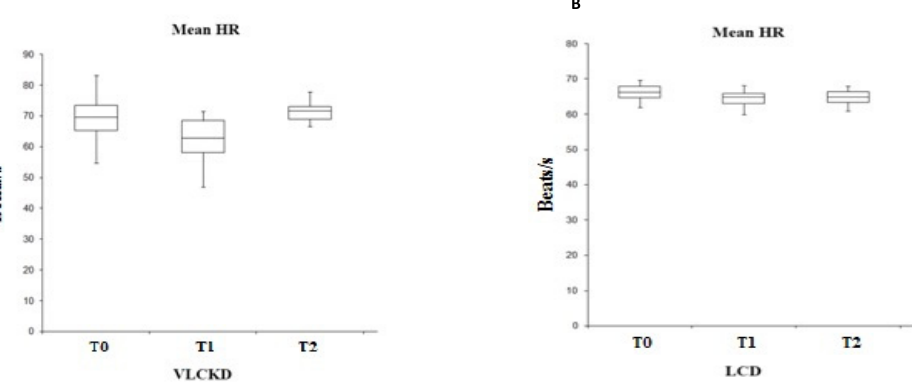
Figure 2. Variability of the mean HR in VLCKD subjects ( A ) and in LCD subjects ( B ). By evaluating the mean-RR parameter (temporal distance between two heartbeats, expressed in ms), the trend in the two groups is similar, with an increase at T1 and a reduction at T2 (Figure 3). However, this variability is statistically significant only in the group subjected to a ketogenic diet (F (2.25) = 0.003, p < 0.01). Analyzing the HF parameter (Figure 4), we find, as expected, a trend similar to that of the RR variability, with a significance in the ketogenic diet group (F (2.25) = 0.002, p < 0.01). Instead, by evaluating the sympathetic activity through the analysis of the LF (Figure 5), its variability is closely correlated with the HR: in fact, the trend is similar with a reduction at T1 and an increase in values at T2. However, this variability is statistically significant only for the group subjected to VLCKD (F (2.25) = 0.023, p <